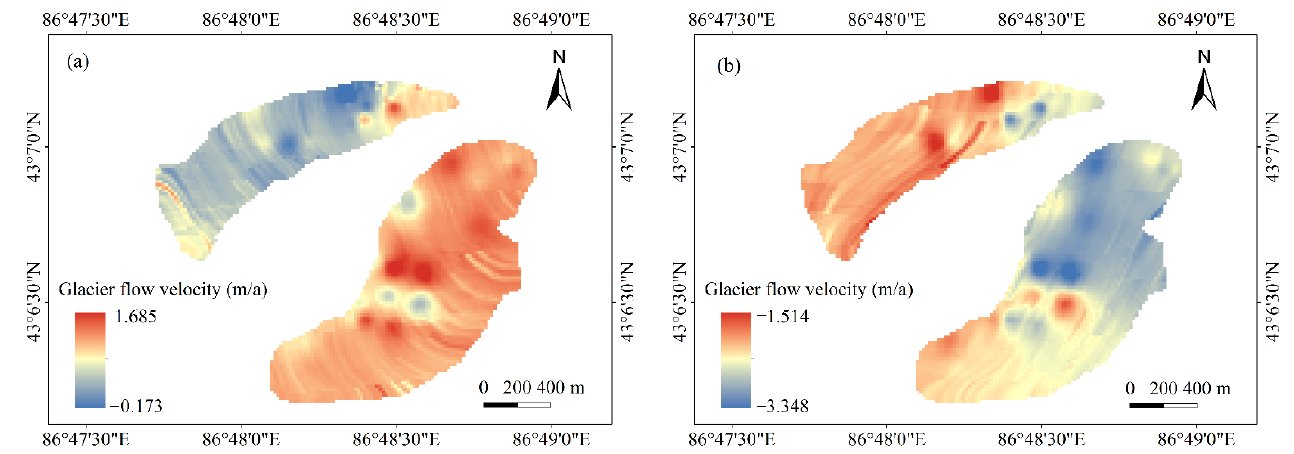
10 of 26 Figure 5. Glacier flow velocity of LOS direction 2016 – 2017: ( a ) LOS measurements from the ascend- ing tracks; ( b ) LOS measurements from the descending tracks. The figure shows that the LOS direction ’ s ascending and descending glacier veloci- ties were 1.812 m/a and − 1.558 m/a from 2006 to 2007. The flow velocity of the ascending images in the west branch was 0.298 m/a higher than the glacier flow velocity of the east branch. In contrast, the velocity of the descending images in the west branch was 0.267 lower than the velocity in the east branch. Notably, the maximum LOS velocity of the ascending images was 2.210 m/a, which appeared at about 4000 m in the west branch. The